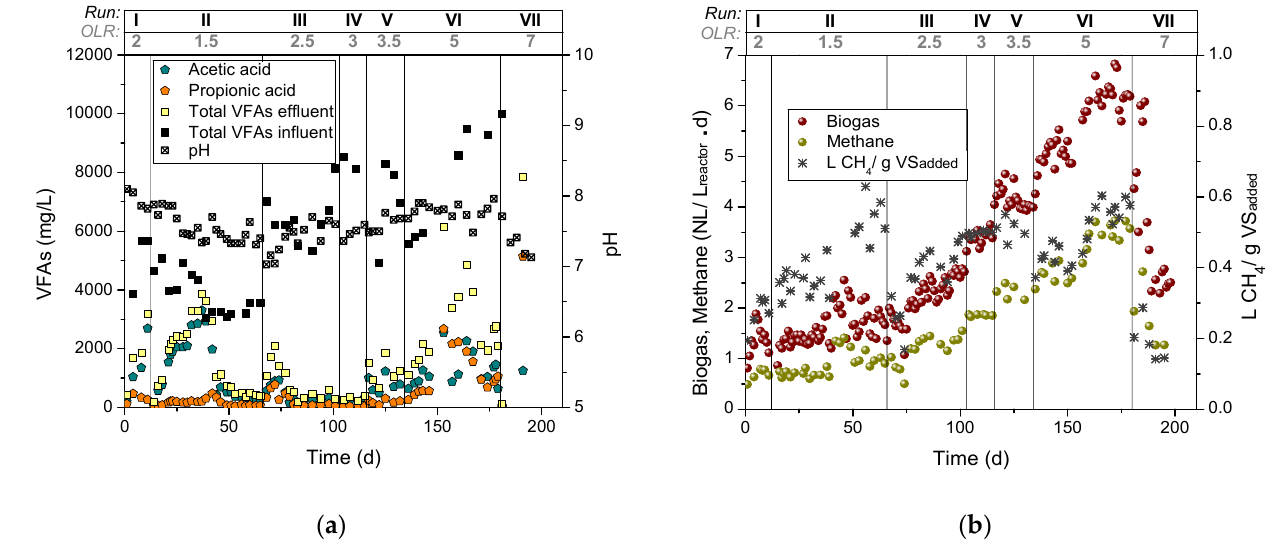
Figure 2. Northern Greece scenario: ( a ) Main accumulated VFAs, total VFAs amount of influent and effluent, and pH values, ( b ) biogas and methane yields for all the tested runs. All the previous data indicate that from the 22 g d-COD/L, the amount of 10.4